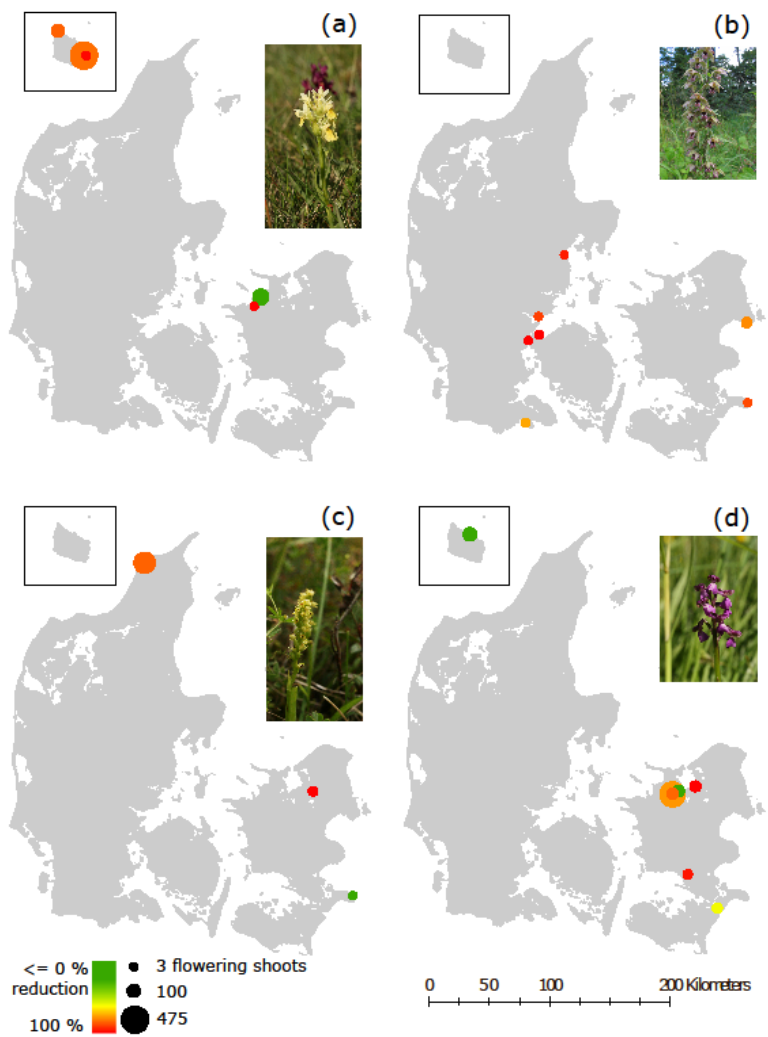
Figure 2. Populations of the four analyzed orchids. Only populations that were monitored at least 3 years within the first and last 10 years of the study period are shown. The size of the dots corresponds to the mean number of flowering shoots (1987–1996), showing the initial population sizes. The color gradient from green to red reflects the reduction of flowering shoots from the initial period (1987–1996) to the 2007–2016 period. The insert shows the island of Bornholm. ( a ) Dactylorrhiza sambucina , ( b ) Epipactis helleborine subsp. helleborine , ( c ) Herminium monorchis , ( d ) Anacamptis morio . Photos: ( a , c , d ) Jesper Moeslund. ( b ) Peter Wind.